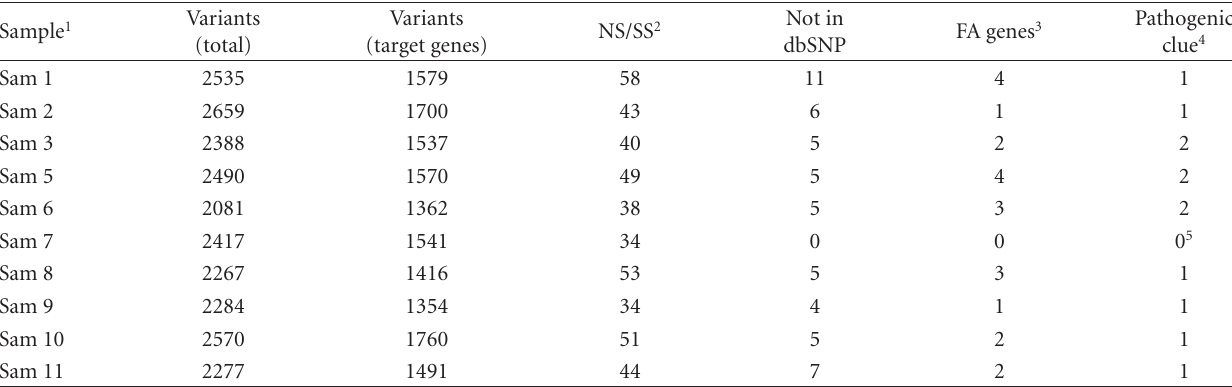
Table 2: Pathogenic mutation detection through filtering.